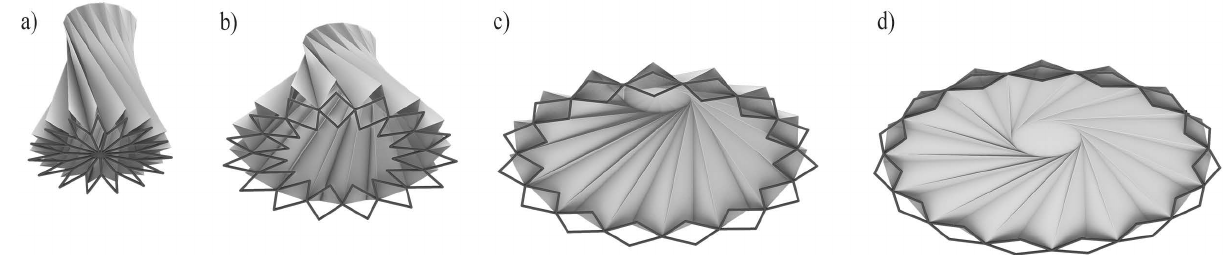
Figure 13: Deployment sequence of a 15-gon flasher CP, anchored on the pivots of an angulated scissors closed-loop